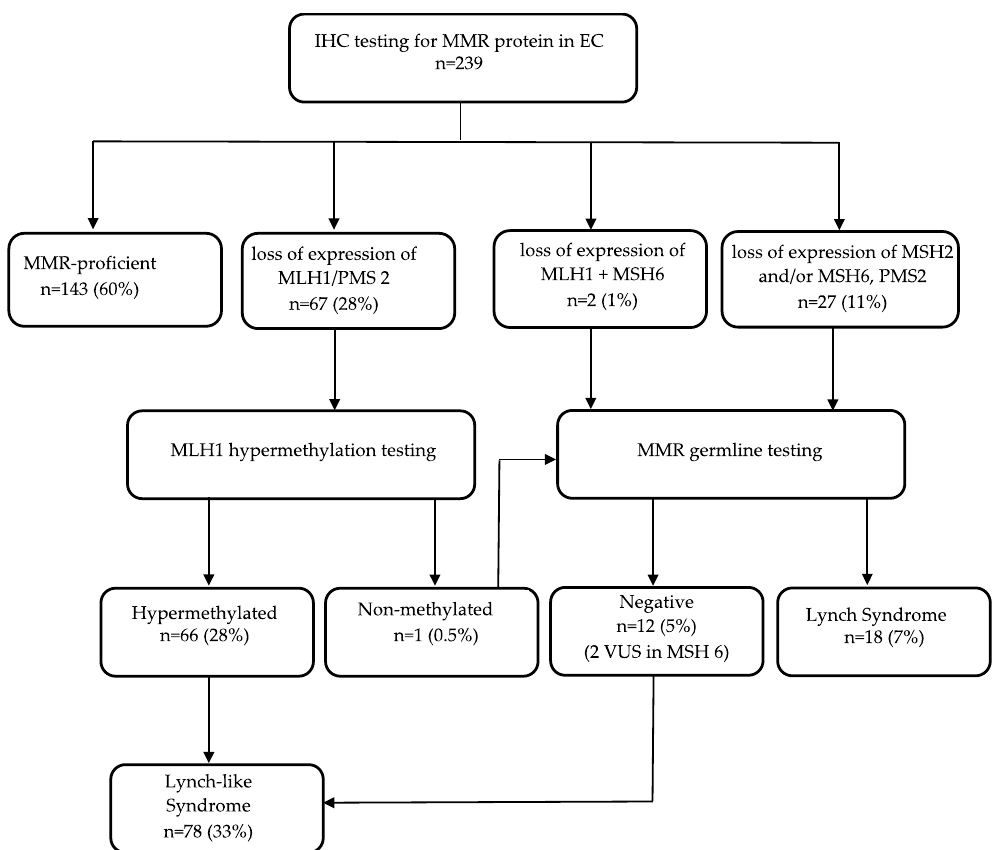
Figure 1. Flow chart of diagnosis of Lynch syndrome, Lynch-like syndrome and mismatch repair proficient cases in our population of endometrial cancers.